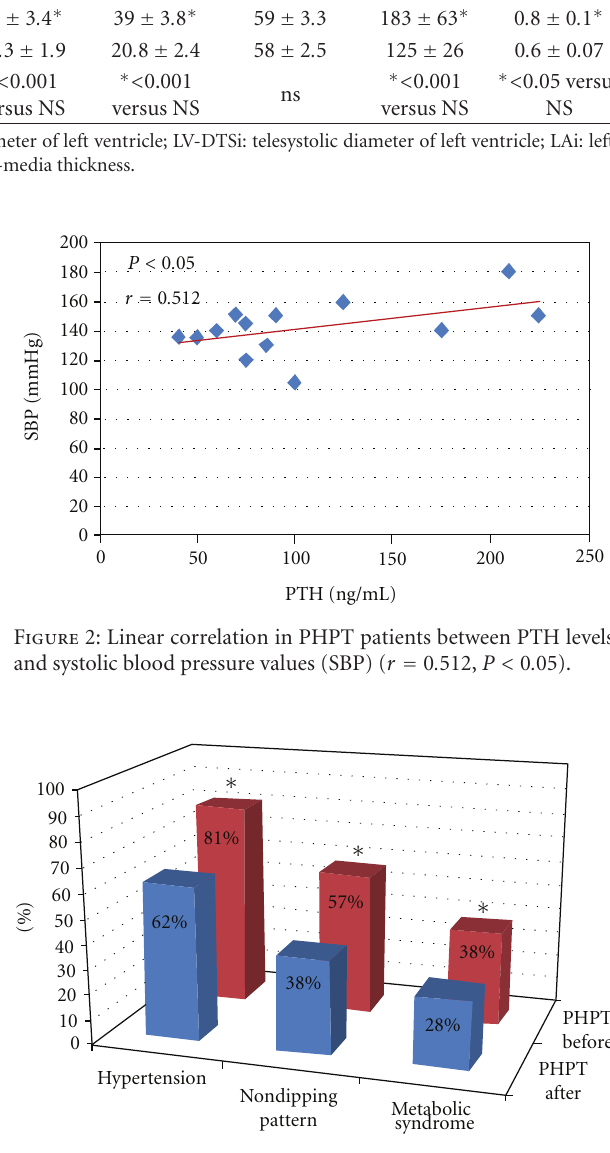
Figure 3: Prevalence of arterial hypertension, “non-dipping pat- tern,” and metabolic syndrome in PHPT patients before (PHPT before) and after surgery (PHPT after). ∗ P < 0 .